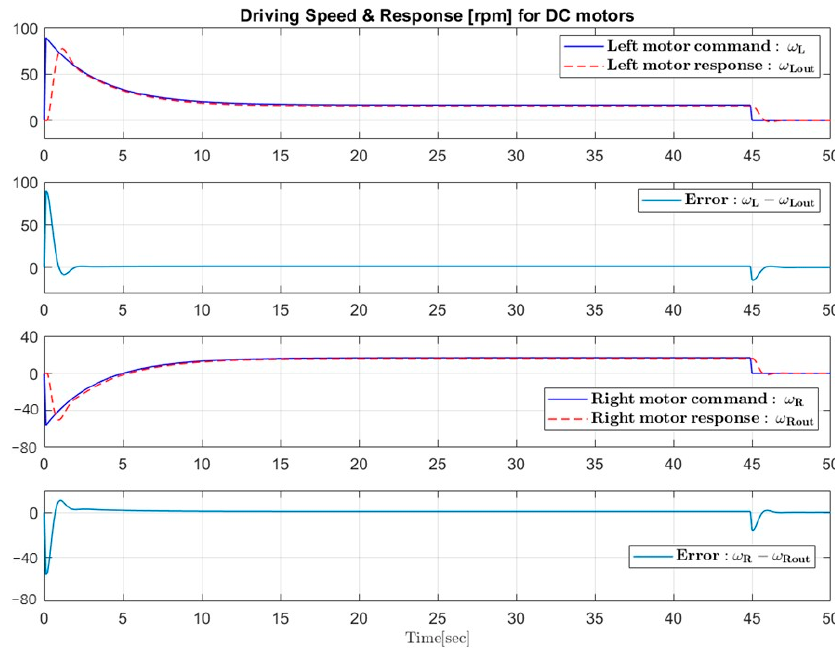
Figure 16. Experiential results of Case I: motor speed commands vs. resulting outputs.